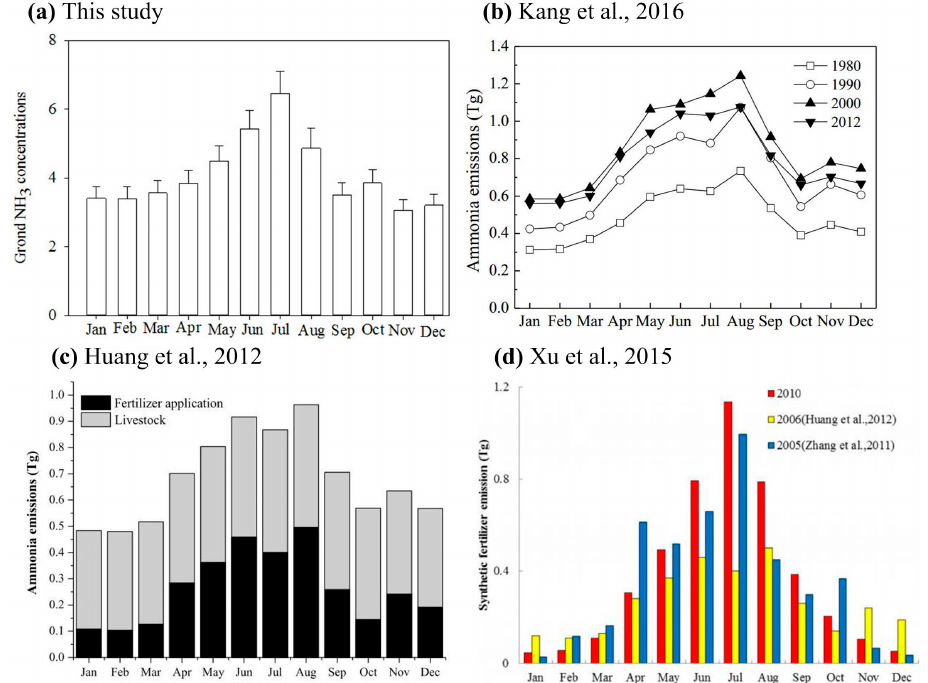
Figure 6. Seasonal patterns of ground NH 3 concentrations in China. ( a ) indicates the monthly variations of ground NH 3 concentrations ( µ g N m − 3 ) in China; ( b ) represents the monthly variations of the total NH 3 emissions (Tg, 10 12 g) in China conducted by Kang et al. [36]; ( c ) shows the the monthly variations of the sum of fertilizer and livestock NH 3 emissions (Tg) in China conducted by Huang et al. [35] and ( d ) denotes the monthly variations of the fertilizer NH 3 emissions (Tg) in China conducted by Xu et al. [37].